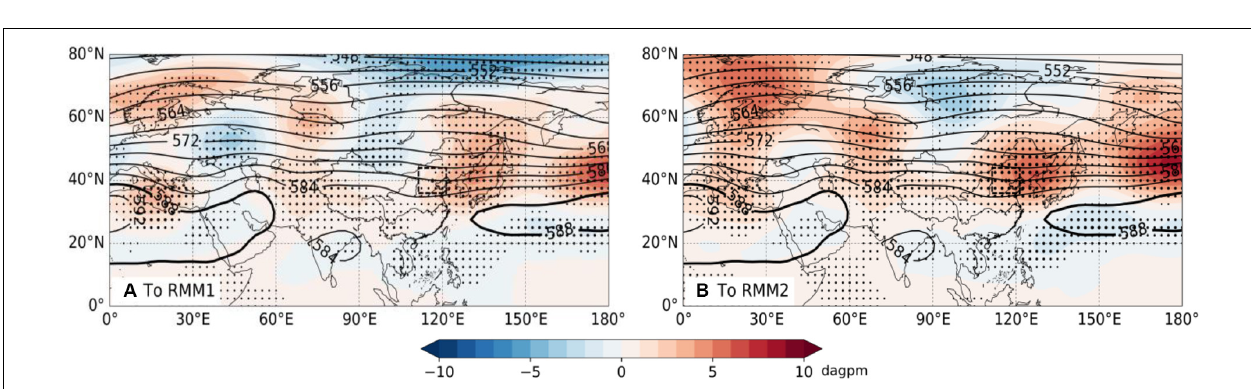
FIGURE 9 | The regressed pattern of anomalous height at 500 hPa onto (A) RMM1 and (B) RMM2 in the summer of 2018 (the dotted areas exceed 95% confidence level). The contours are the summer means of 500 hPa height for the years 1981–2010. Unit: